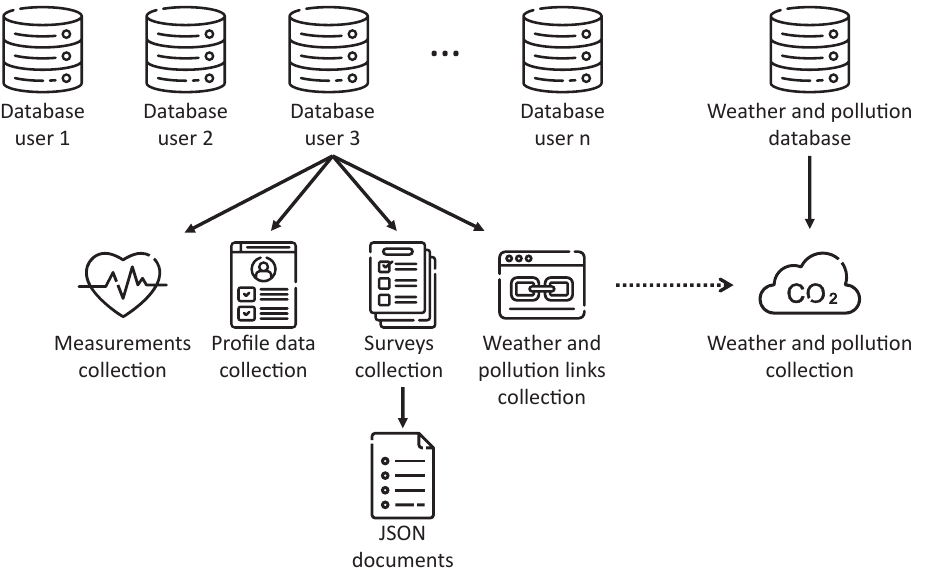
Figure 9. Structure of the database system implemented in the proposed web ecosystem. Prediction of Blood Pressure